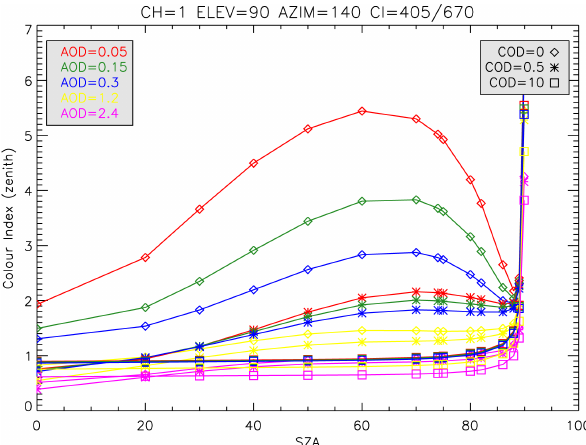
Figure 2. Simulations of the colour index ( I 405 /I 670 ) under varying aerosol optical depth (AOD) and cloud optical depth (COD). The simulations were performed with the DAK plan-parallel radiative transfer model (Stammes, 2001), using a cloud-layer height of